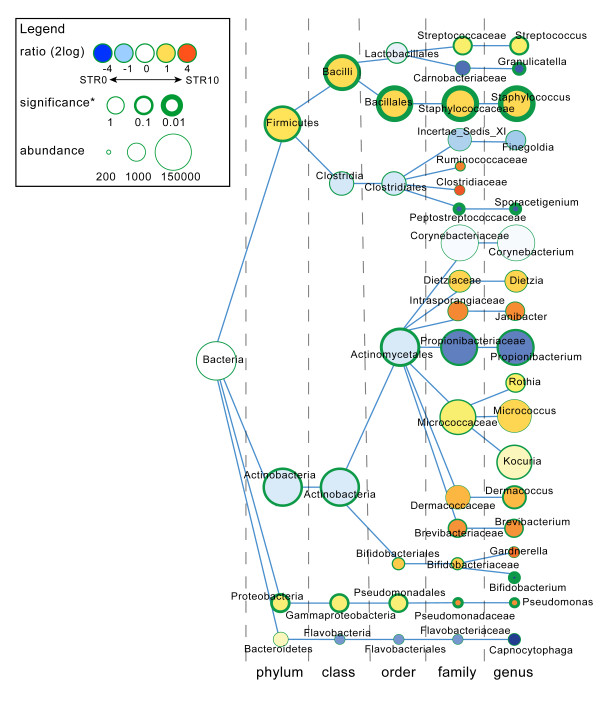
Differences in microbial community composition between STR0 and STR10 samples. Nodes represent taxa, edges link the different taxonomic levels. The fold increase is calculated as the 2log of the ratio of the relative in males and females (0 = no difference between STR0 and STR10, 1 = twice as abundant in STR10, and so on). The significance is expressed as the P-value of a Mann-Whitney U test of the male and female samples. Note that the relation between node size and total abundance is non-linear.